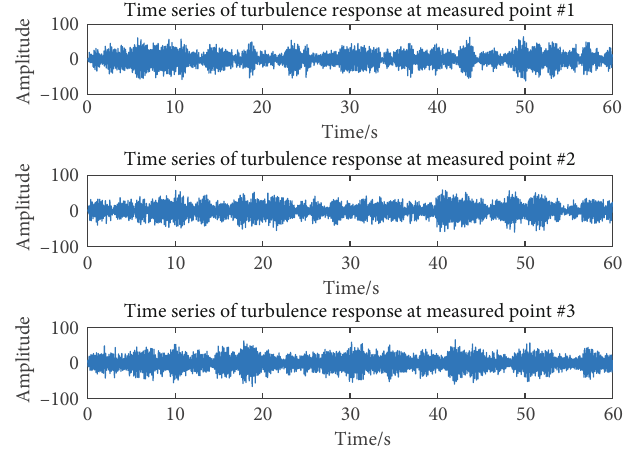
Figure 1: Time series of the two-mode turbulence